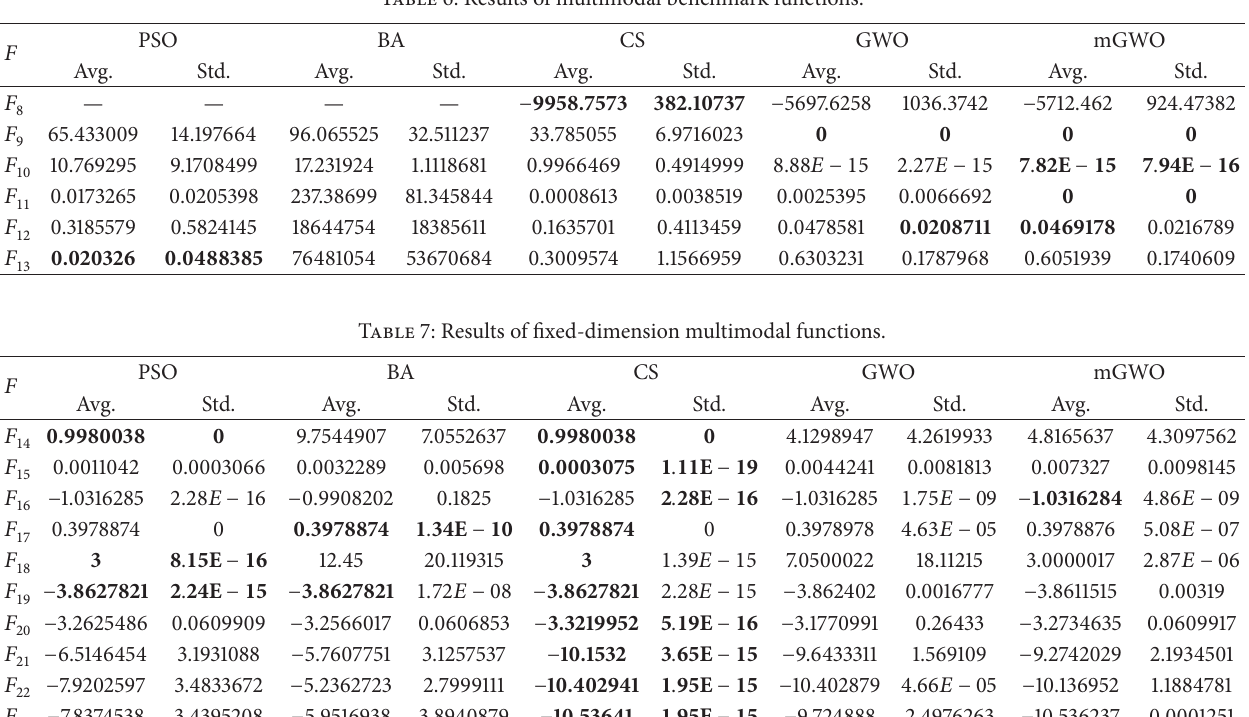
Figure 2: Convergence graph of unimodal benchmark functions. Table 6: Results of multimodal benchmark functions.